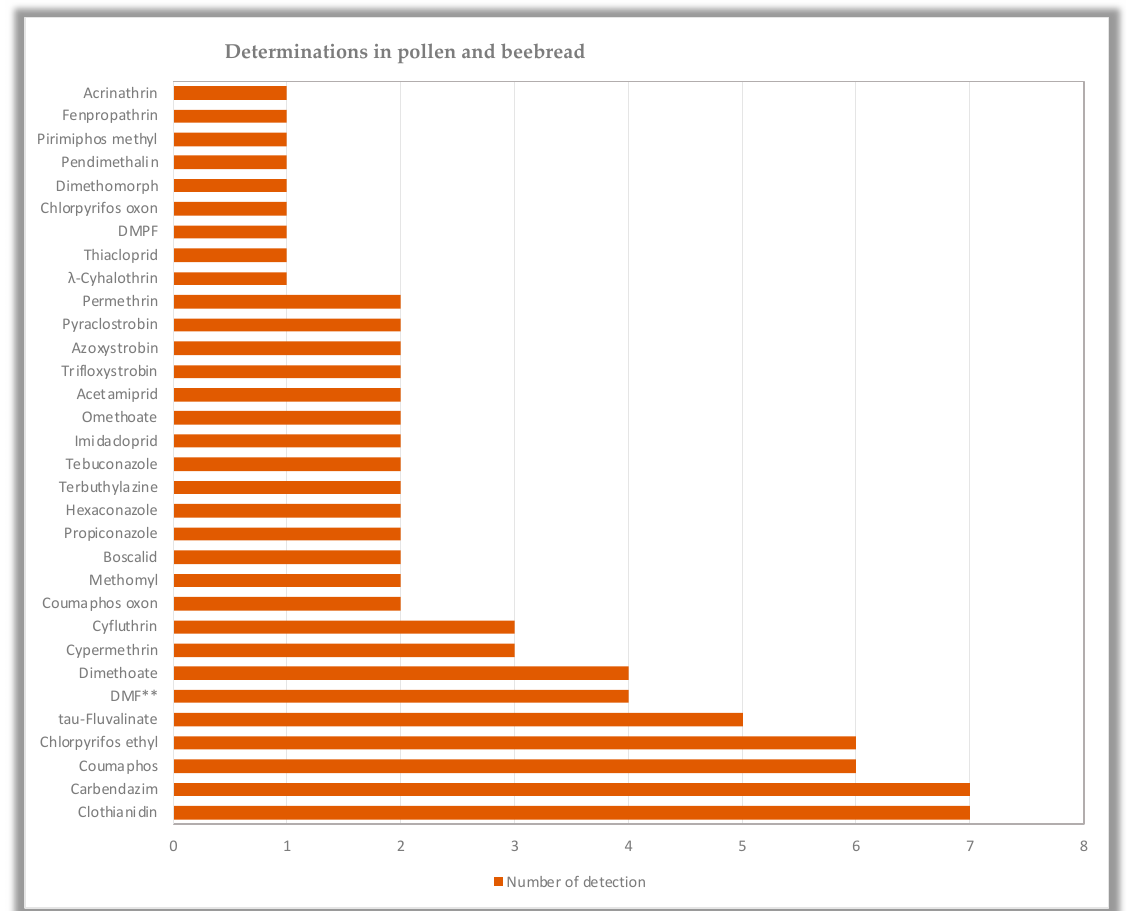
Figure 3. Graph showing determinations of active substances in pollen beebread.